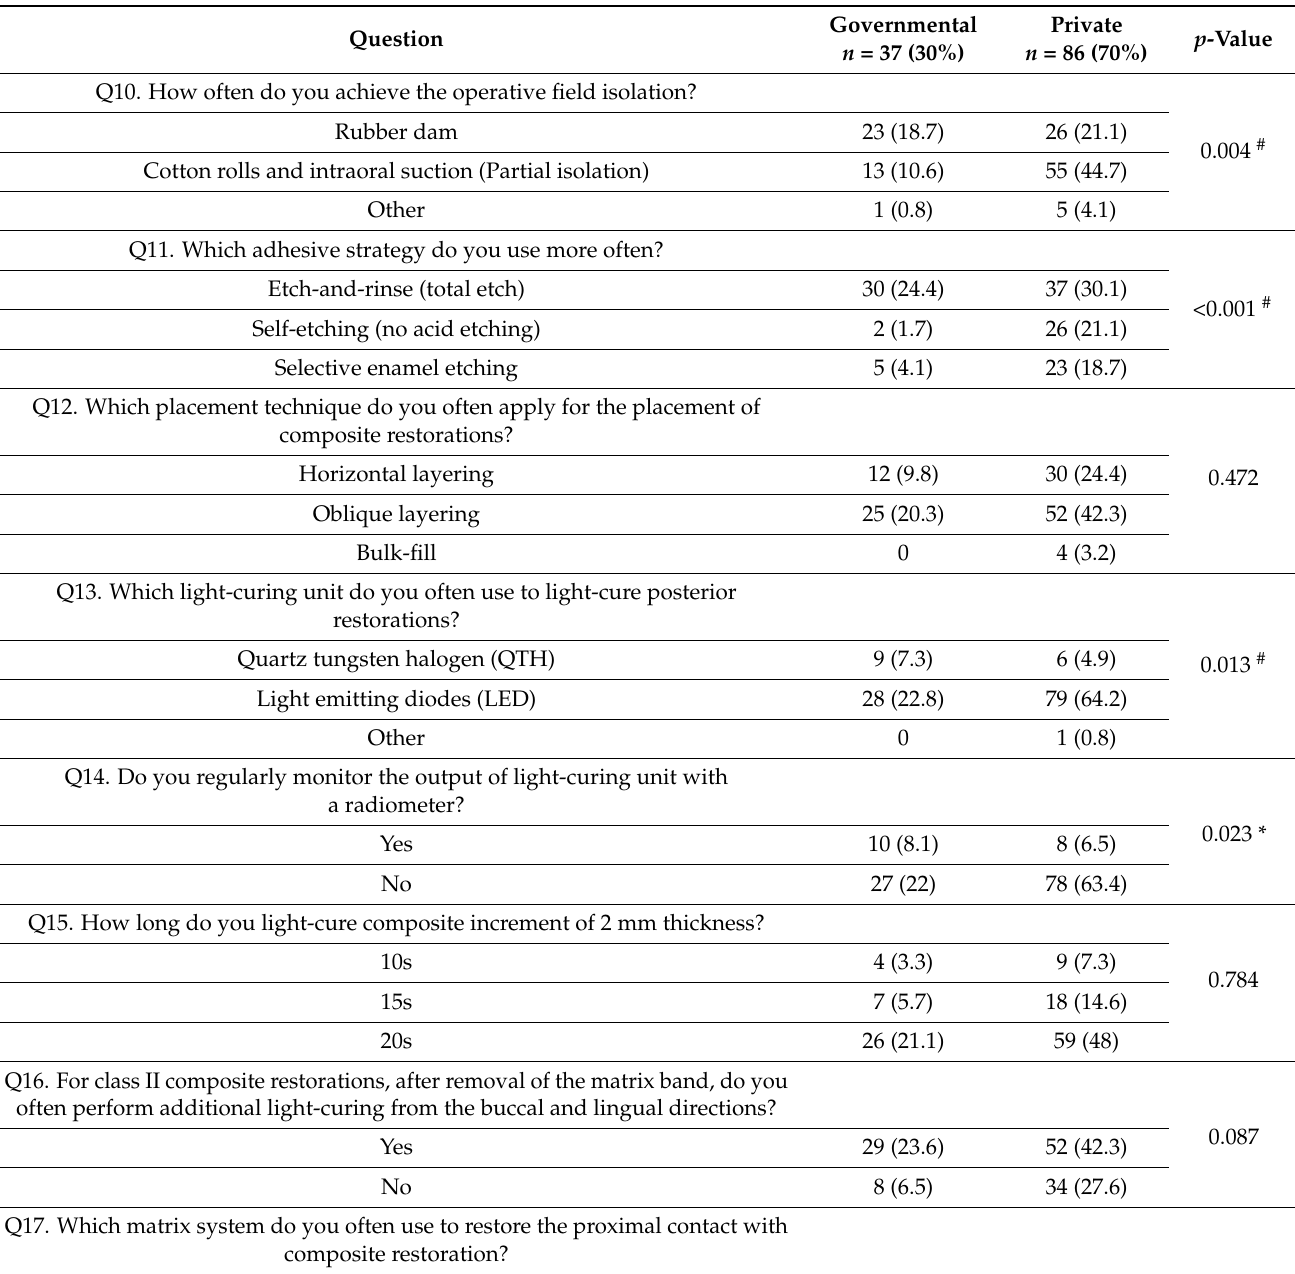
Table 4. Comparison between DPs working in the governmental and private sectors in regard to the restorative technique applied during the placement of posterior composite